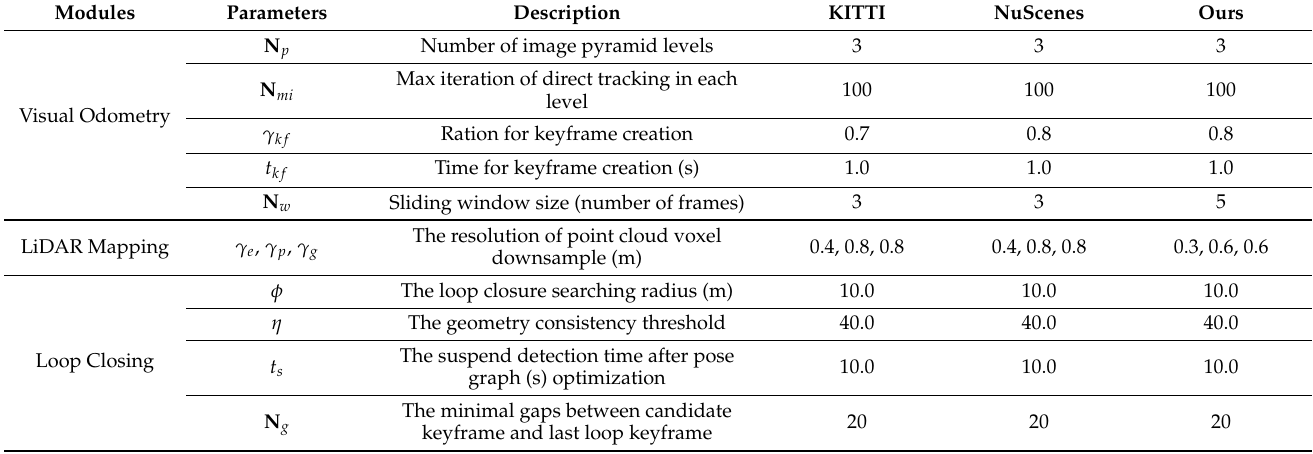
Table 1. Parameters for